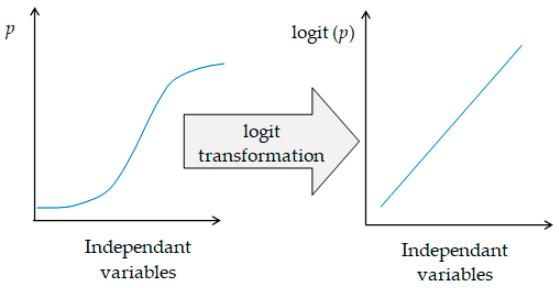
Figure 1. Logit transformation. Source: Own processing according to [76,77].